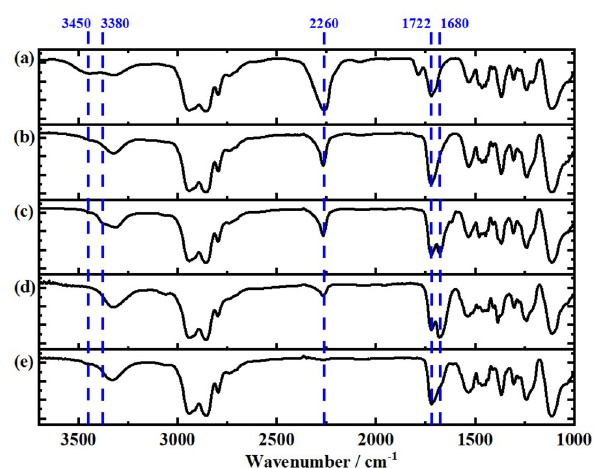
Figure 1. FTIR spectra of the monomers and/or products of P22-4 before and after each chain extension reaction: ( a ) a mixture of isophorone diisocyanate (IPDI), poly(tetramethylene ether glycol) (PTMEG), and 2,2′-Bis(hydroxymethyl)butyric acid (DMBA) monomers; ( b ) the products after the first chain extension reaction; ( c ) the mixture of the products after the first chain extension reaction and 22DTDA monomers; ( d ) the products after the second chain extension reaction; ( e ) the final products after the third chain extension reaction.